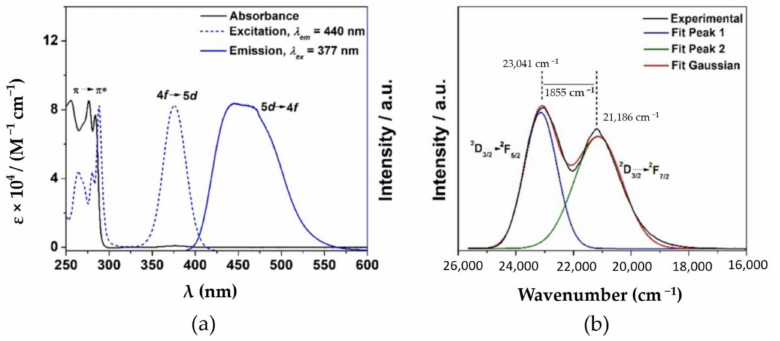
Figure 6. ( a ) UV–Vis absorption, excitation, and emission spectra of the Ce III complex in ethanol and its ( b ) fluorescence in 2-methyl-THF at 77 K with excitation at 377